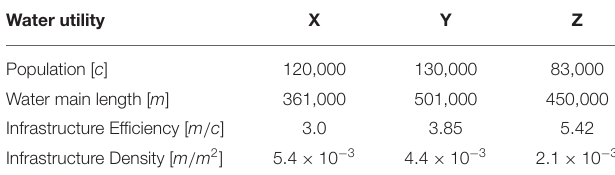
TABLE 4 | Demographic information of water utilities.